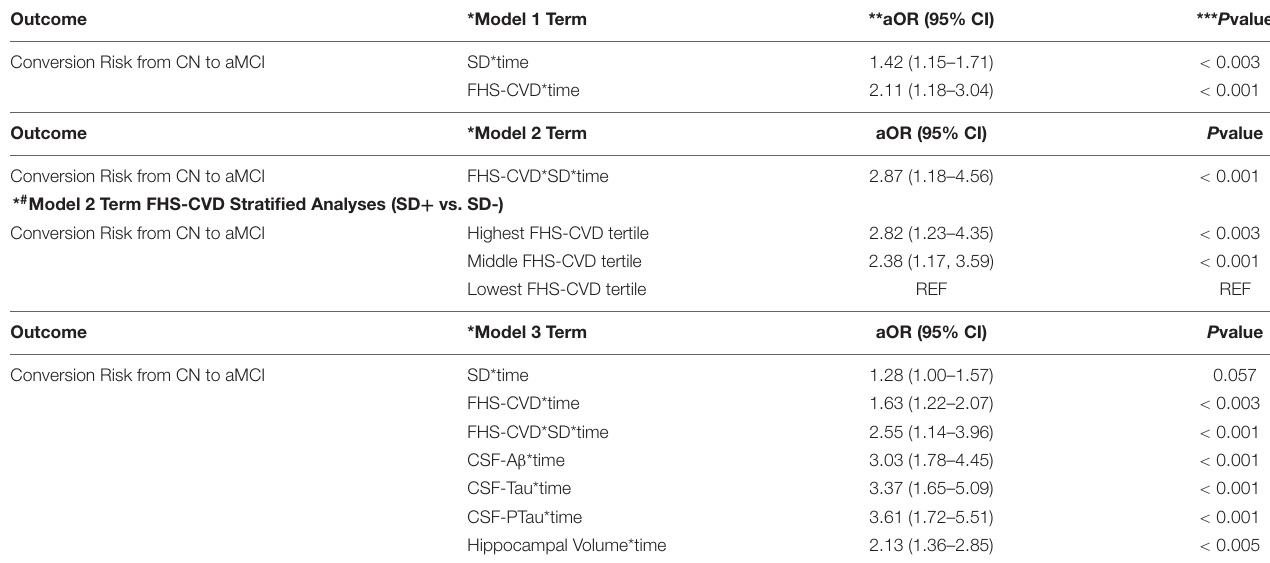
TABLE 4 | Interactive associations of NPI-Q assessed sleep disturbance (SD) and vascular risk with an aMCI diagnosis during follow-up in clinically normal older adults, NACC UDS data.